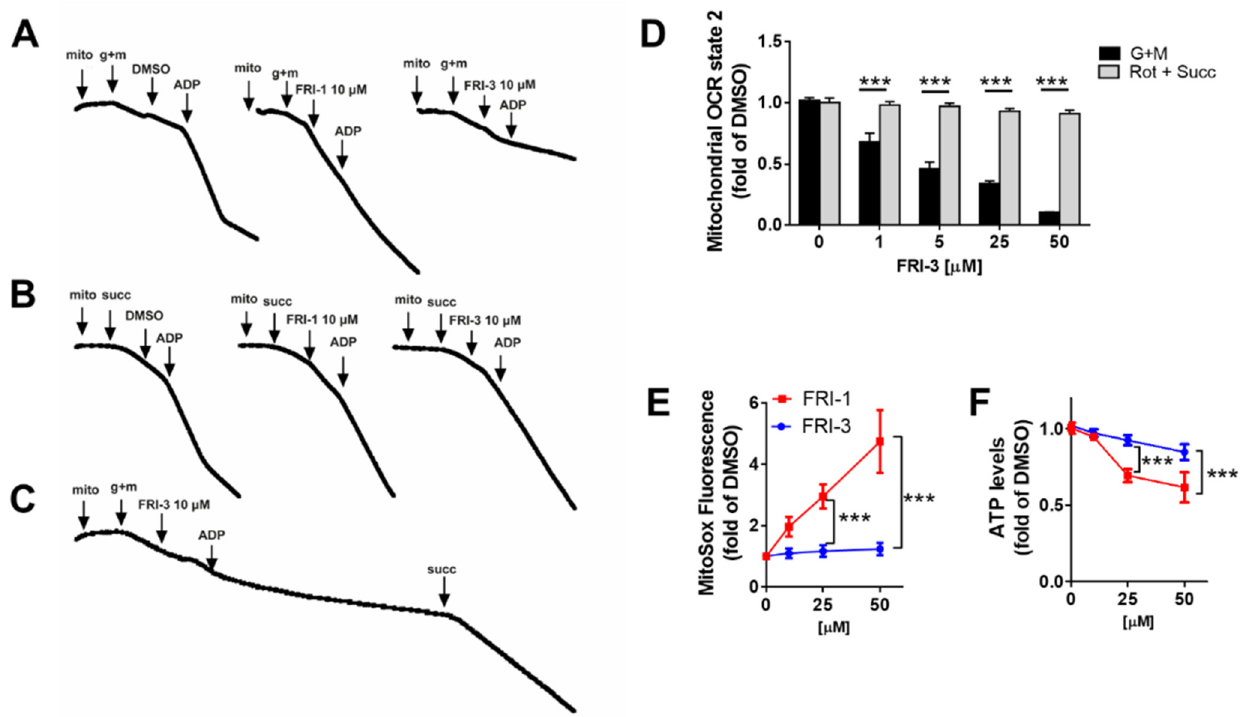
Figure 6. FRI-3 is an FRI-1 analog that acts on Complex I, lacking effects on ROS and ATP levels. ( A – D ) Effect of FRI-1 and FRI-3 on OCR in state 3. OCR was evaluated by Clark electrode; ( E , F ) Effect of FRI-1 and FRI-3 on the mitochondrial superoxide and ATP levels in MCF7 cells at 4 h of treatment. The data shown are the mean ± SD of three independent experiments. *** p < 0.001, vs. control (DMSO).